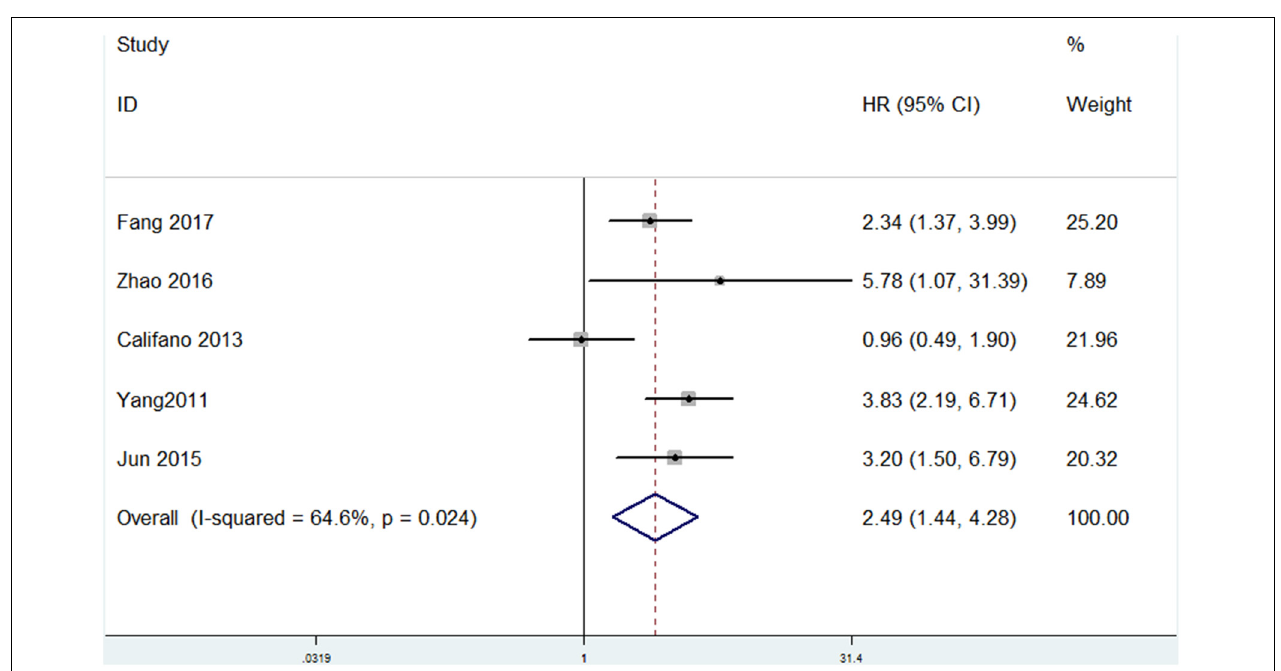
FIGURE 3 | Forest plot of HR for the correlation between HMGA2 expression and Disease-free survival (DFS) in cancers.